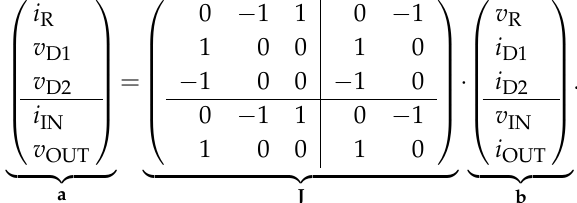
(cid:0) (cid:1) (cid:0) (cid:1) (cid:12) (cid:12) (cid:12) (cid:12) x ( k + 1 ) x ( k ) (cid:12) (cid:12) H −H (cid:0) x ( 0 ) H